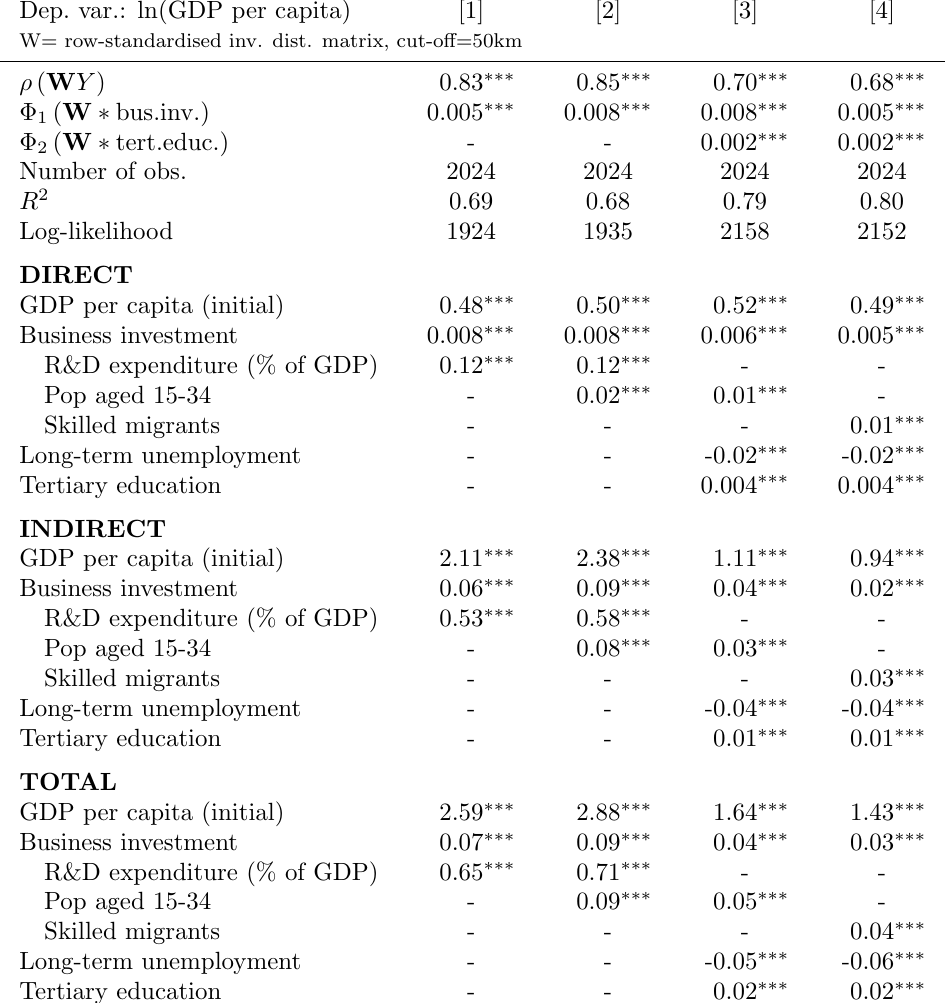
Table A.3: Empirical Results – Random effect – EU sample without country dummies Dep. var.: ln(GDP per capita) [1] [2] [3] [4] W= row-standardised inv. dist. matrix, cut-off=50km ρ ( W Y ) 0.83 ∗∗∗ 0.85 ∗∗∗ 0.70 ∗∗∗ 0.68 ∗∗∗ Φ 1 ( W ∗ bus.inv.) 0.005 ∗∗∗ 0.008 ∗∗∗ 0.008 ∗∗∗ 0.005 ∗∗∗ Φ 2 ( W ∗ tert.educ.) Number of